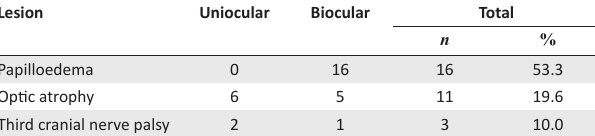
TABLE 7 : Neuro-ophthalmologic lesions of human immunodeficiency virus and acquired immunodeficiency syndrome participants in this study ( n = 30). Lesion